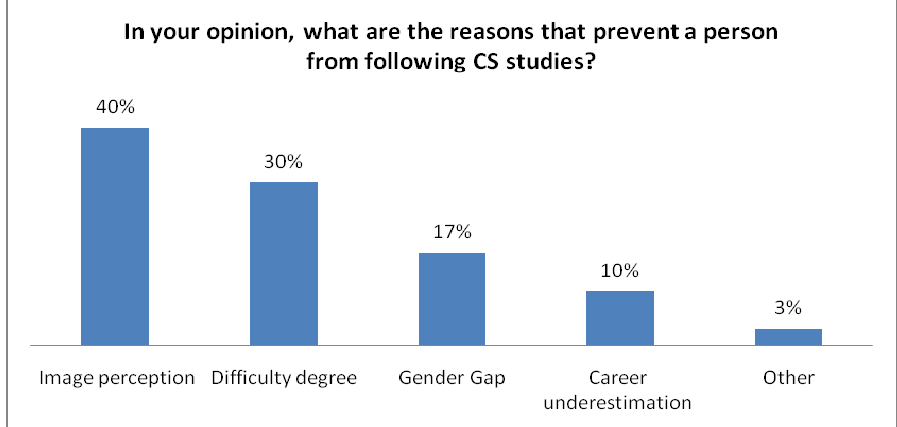
Figure 5. Reasons to reject CS in university in